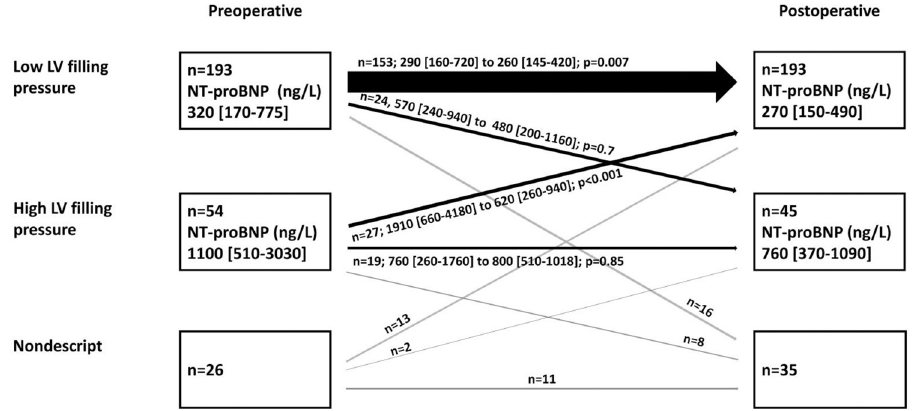
Fig 1. Diastolic function categorized as low or high left ventricle (LV) filling pressure before surgery and 6 months after surgical aortic valve replacement (SAVR), along with the corresponding levels of NT-proBNP (ng/